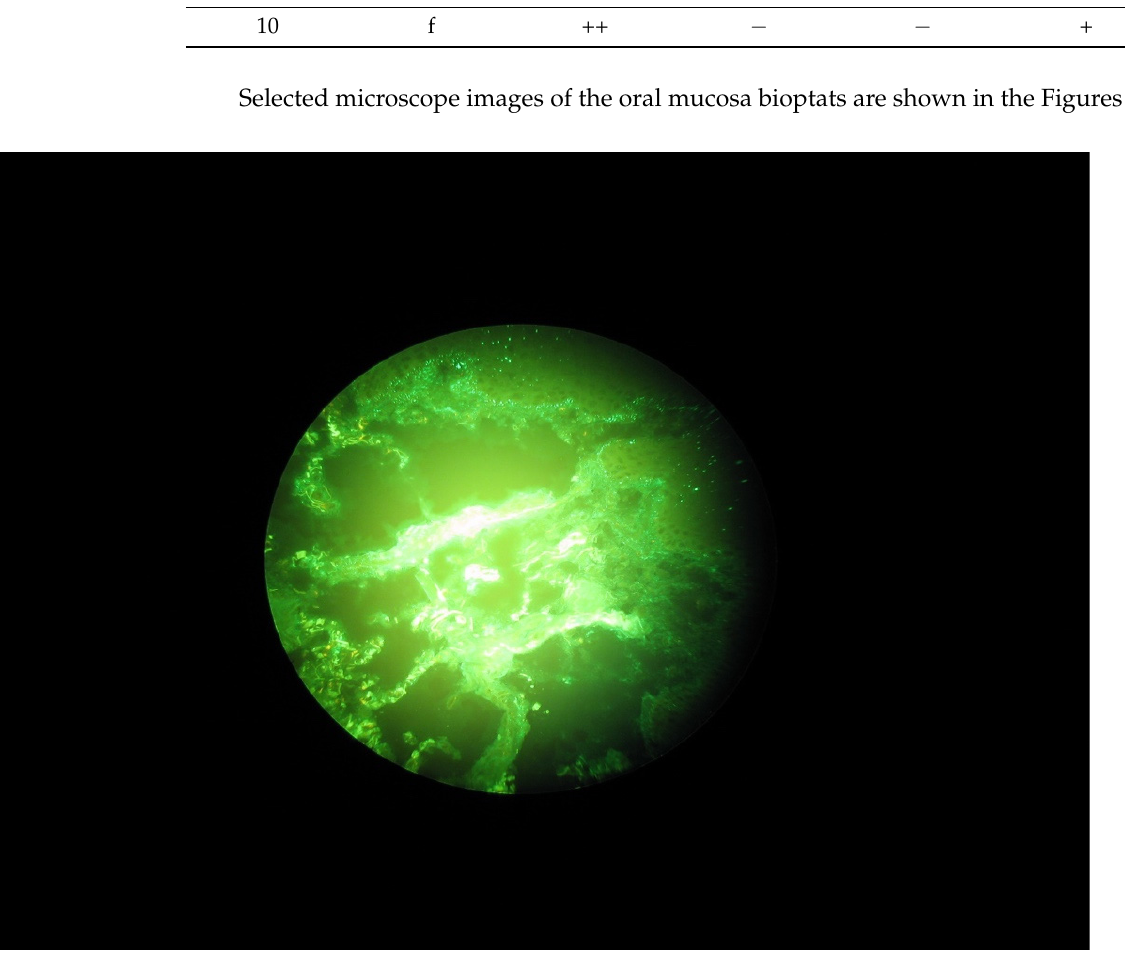
Figure 1. Granular C3 deposits along the basal membrane of the oral mucosa in a DH patient.